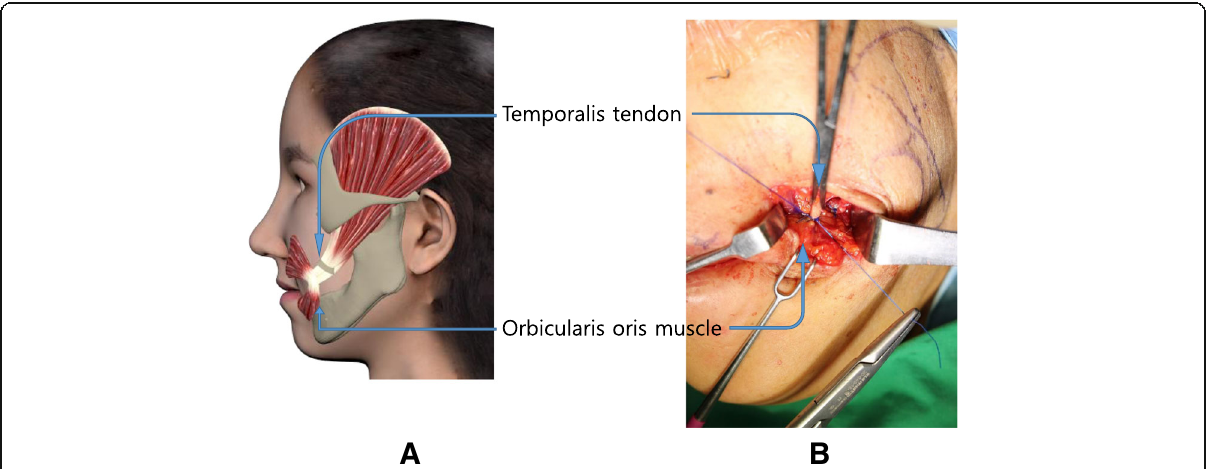
Fig. 3 Fixation of temporalis tendon and coronoid process to orbicularis oris muscles. ( a 3D simulation feature, b suture to the orbicularis oris muscle) ( a transfer temporalis tendon with tip of coronoid process, b suture to the orbicularis oris muscle)